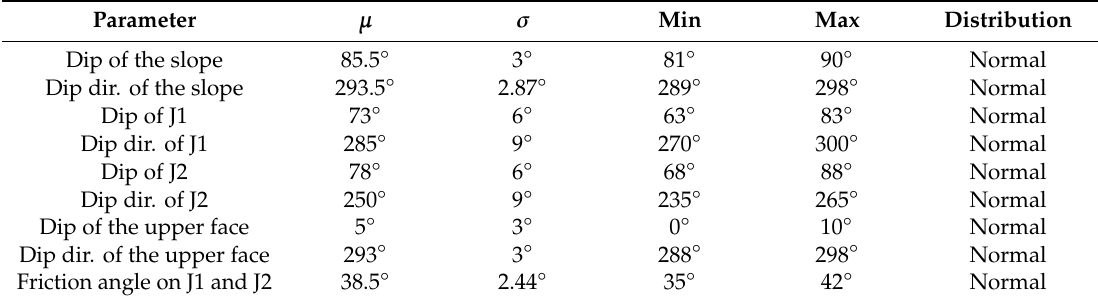
Table 3. Calculation parameters used for the probabilistic analysis of blocks prone to wedge failures. Key: μ = mean value; σ = standard deviation.